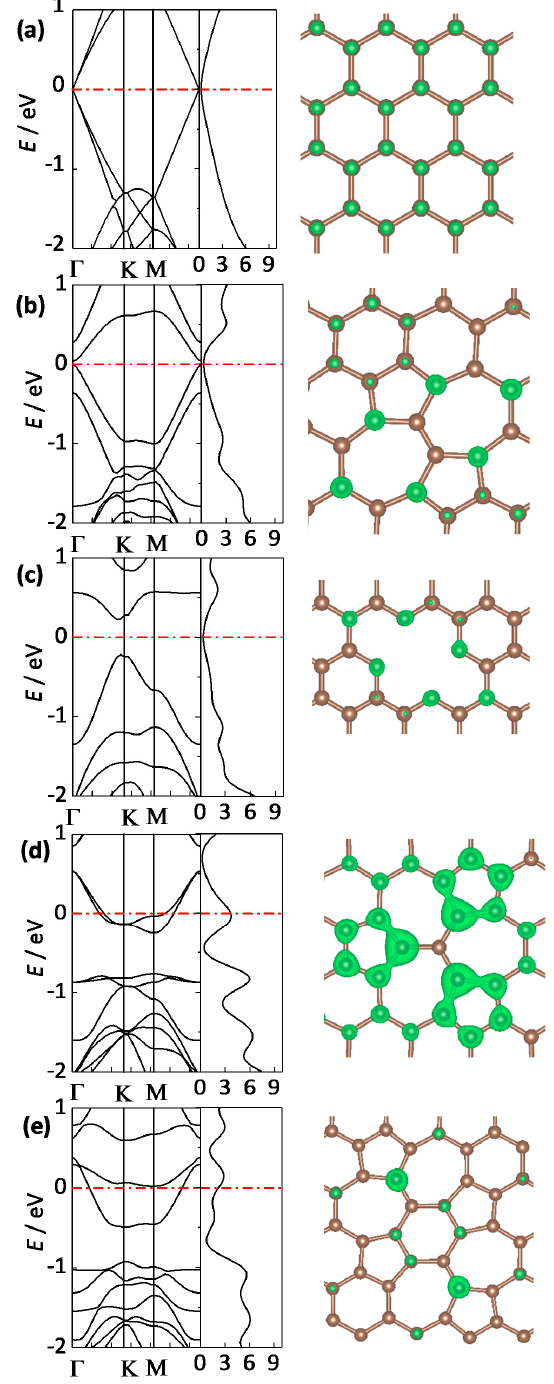
Figure 3. Band structure, density of states (DOS) and band-decomposed charge density (BDCD) iso-sources (0.006 e/Bohr 3 ) of ( a ) pristine; ( b ) SW; ( c ) D2_I; ( d ) D2_II and ( e ) D2_III defected graphene.